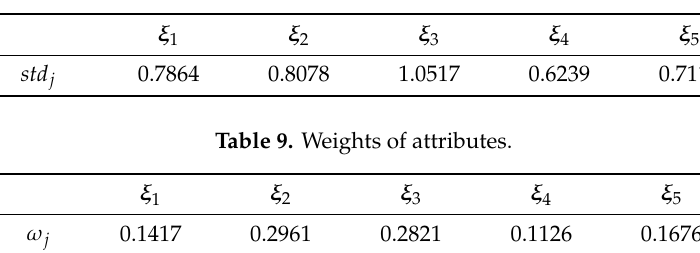
Table 8. Standard deviation of each attribute.